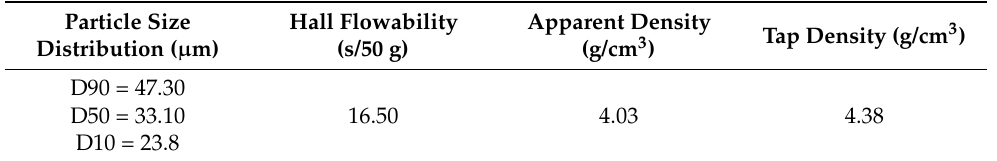
Table 1. Some physical properties of mixed powders having about 60 wt.% Ni + 40 wt.% Ti in its